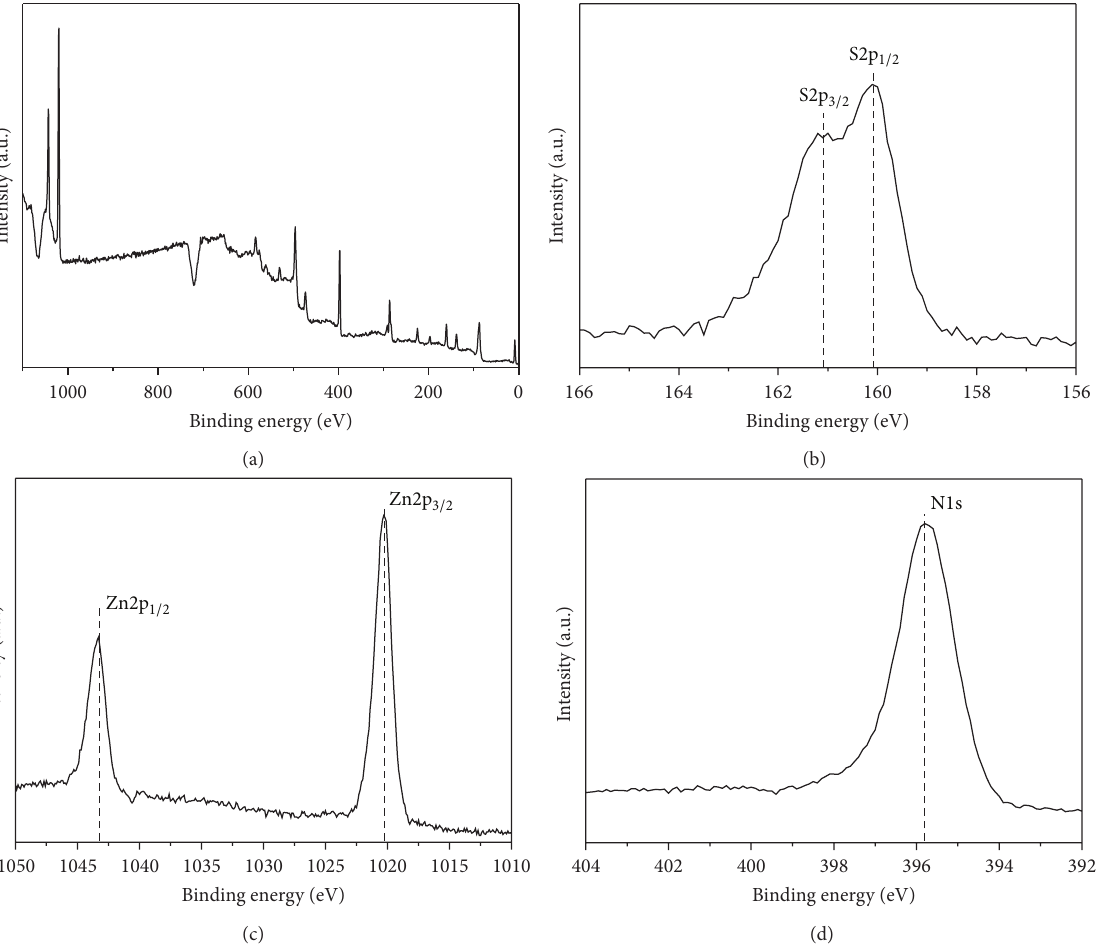
Figure 3: The survey XPS spectra of (a) 15N/ZnS photocatalysts and the high-resolution XPS spectra of (b) S2p, (c) Zn2p, and (d) N1s of 15N/ZnS